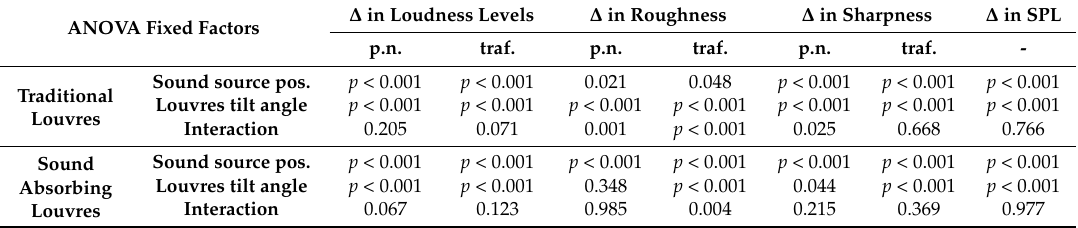
Table 1. p -values calculated from the analysis of the variance for each data set of the calculated ∆ s. The term “Interaction” is to be intended as the interaction between the sound source position and the louvres’ tilt